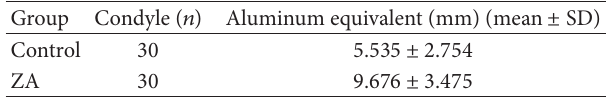
Figure 5: A 50 𝜇 m thick histologic section prepared for histomor- phometric analysis from ZA-treated group (toluidine blue stain, original magnification × 2). Table 1: Comparison of the densitometric data.